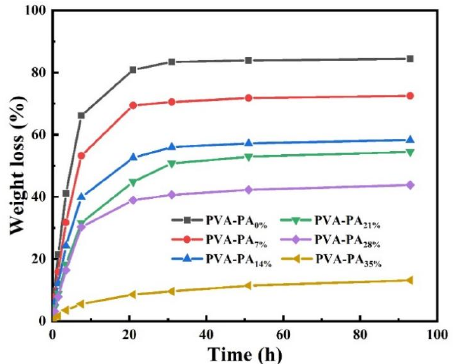
Nanomaterials 2023 , 13 , 380 Figure 1. Weight loss of PVA-PAX hydrogels with different PA contents (20 ℃ , humidity 15%). Figure 1. Weight loss of PVA-PAX hydrogels with different PA contents (20 °C, humidity 15%).